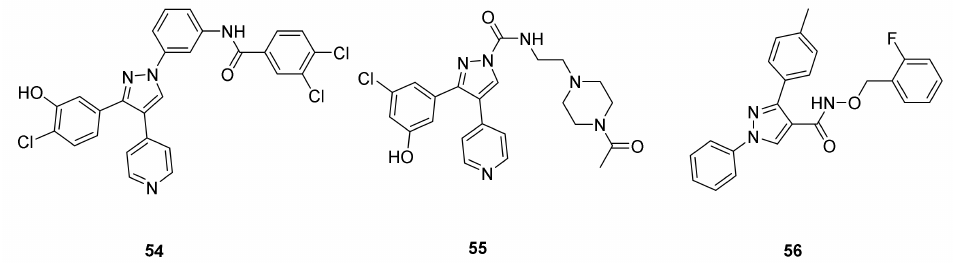
Figure 61. Structures of pyrazole-based MEK/ERK